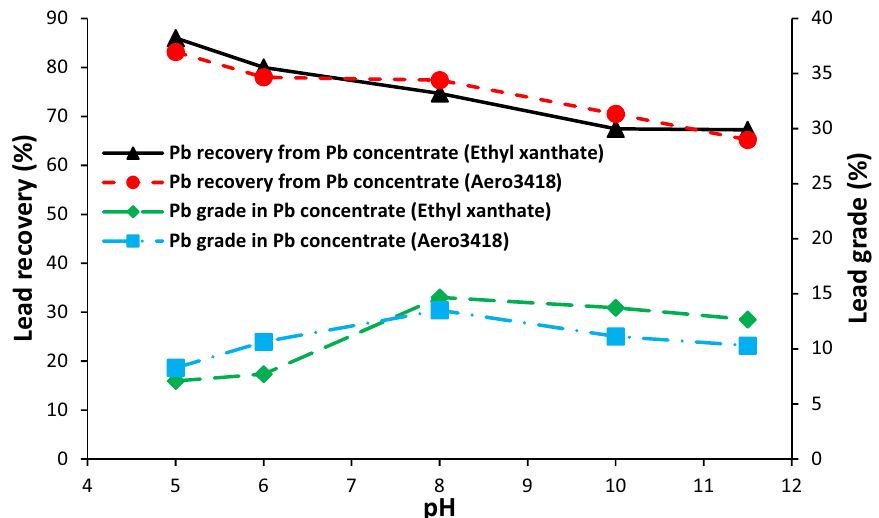
Figure 4. Effect of pH and collector type on the Pb recovery and grade.